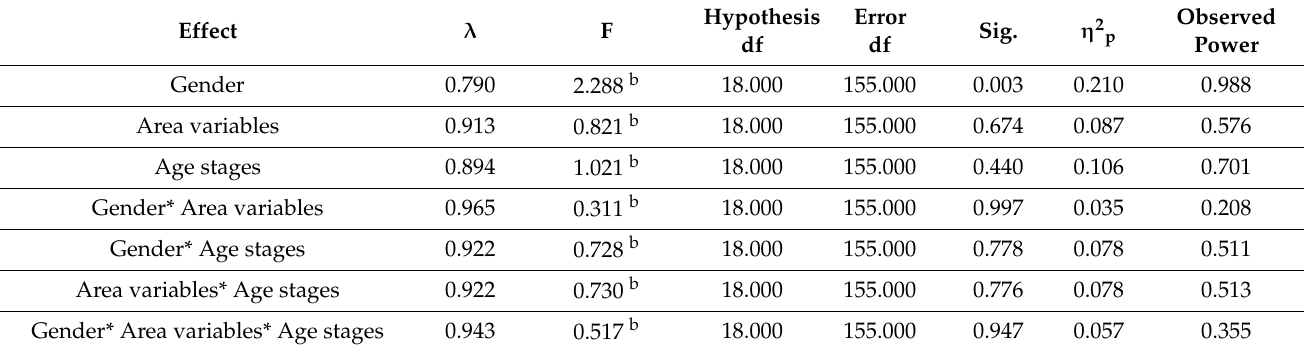
Table 8. The results of the Multivariate Tests (MANOVA)/F4 (leisure sports